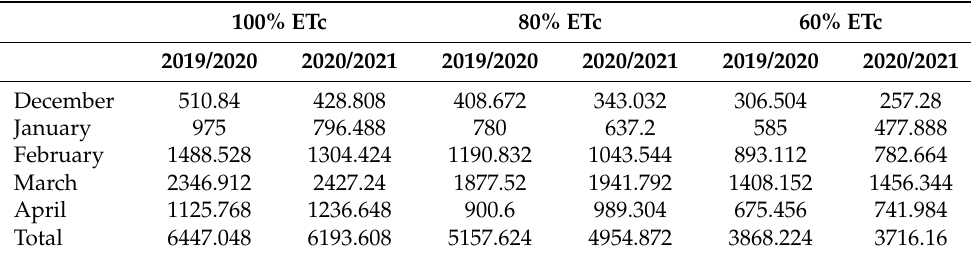
Table 4. Irrigation water applied (m 3 /ha) at different growth months of quinoa grown under different irrigation regimes during the two seasons of 2019/2020 and